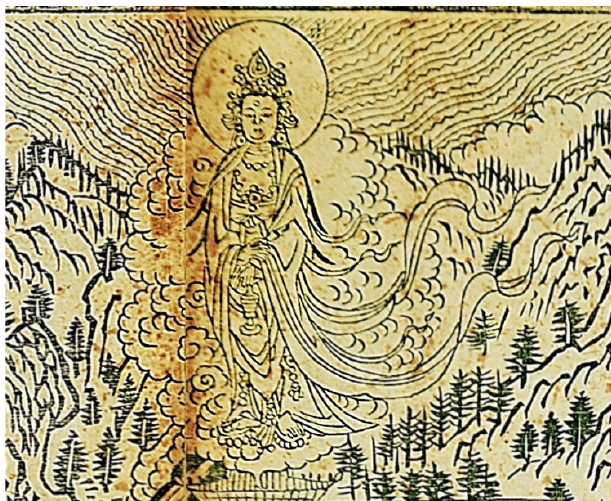
Figure 11. Manifestation of Avalokitesvara from Record of the Manifestation of Avalokitesvara (Arranged by the author).